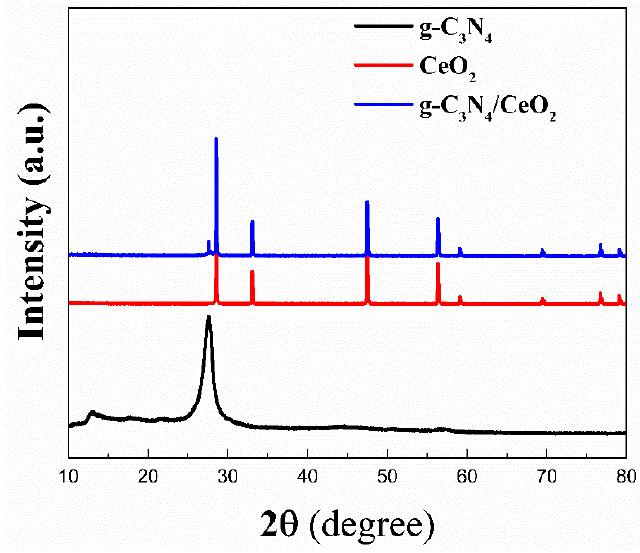
Figure 7. XRD pattern of g-C 3 N 4 / CeO 2 .